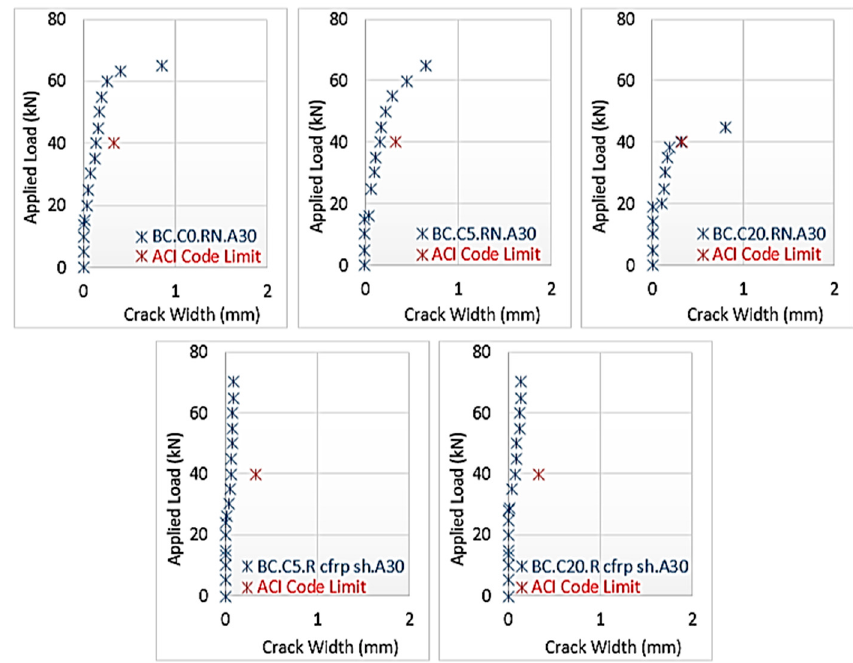
Figure 9. Maximum crack width for specimens in group B.